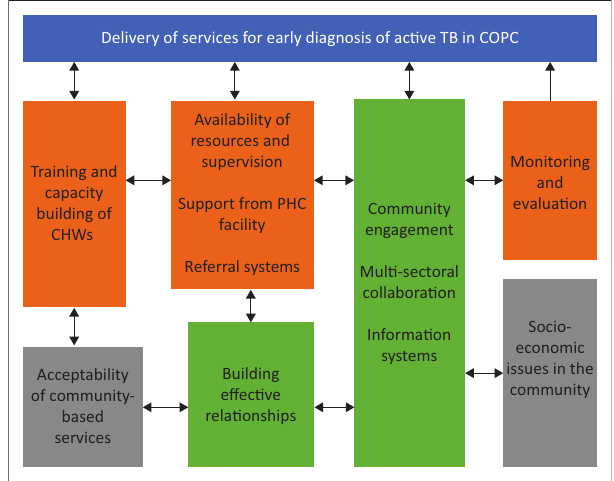
FIGURE 1: Conceptual framework of key